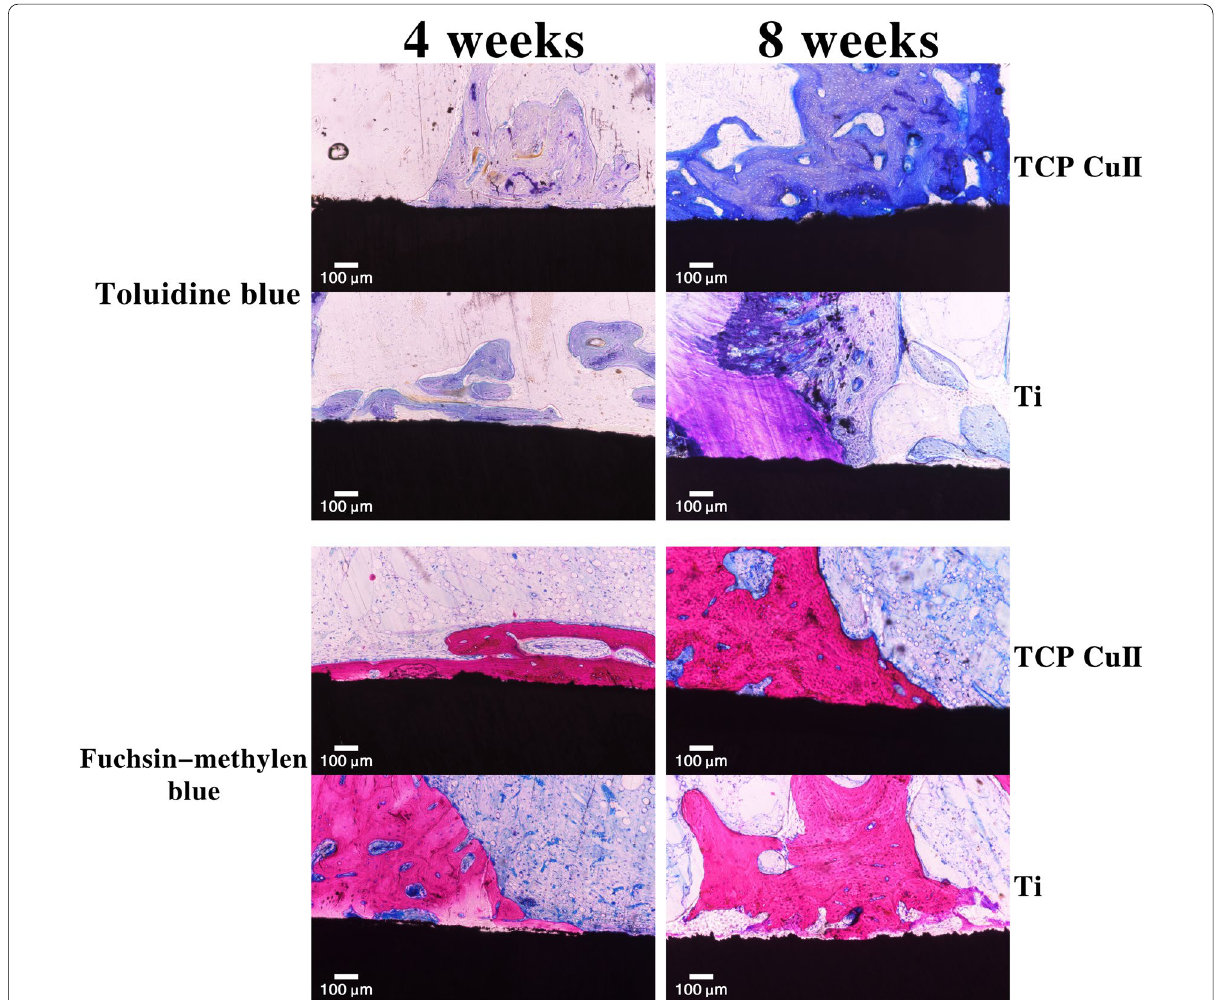
Fig. 11 Toluidine blue and fuchsin‑methylene blue staining of new bone formation at 4 and 8 weeks after